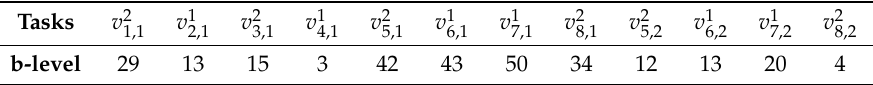
Table 3. The b-level of each task in one hyper-period.